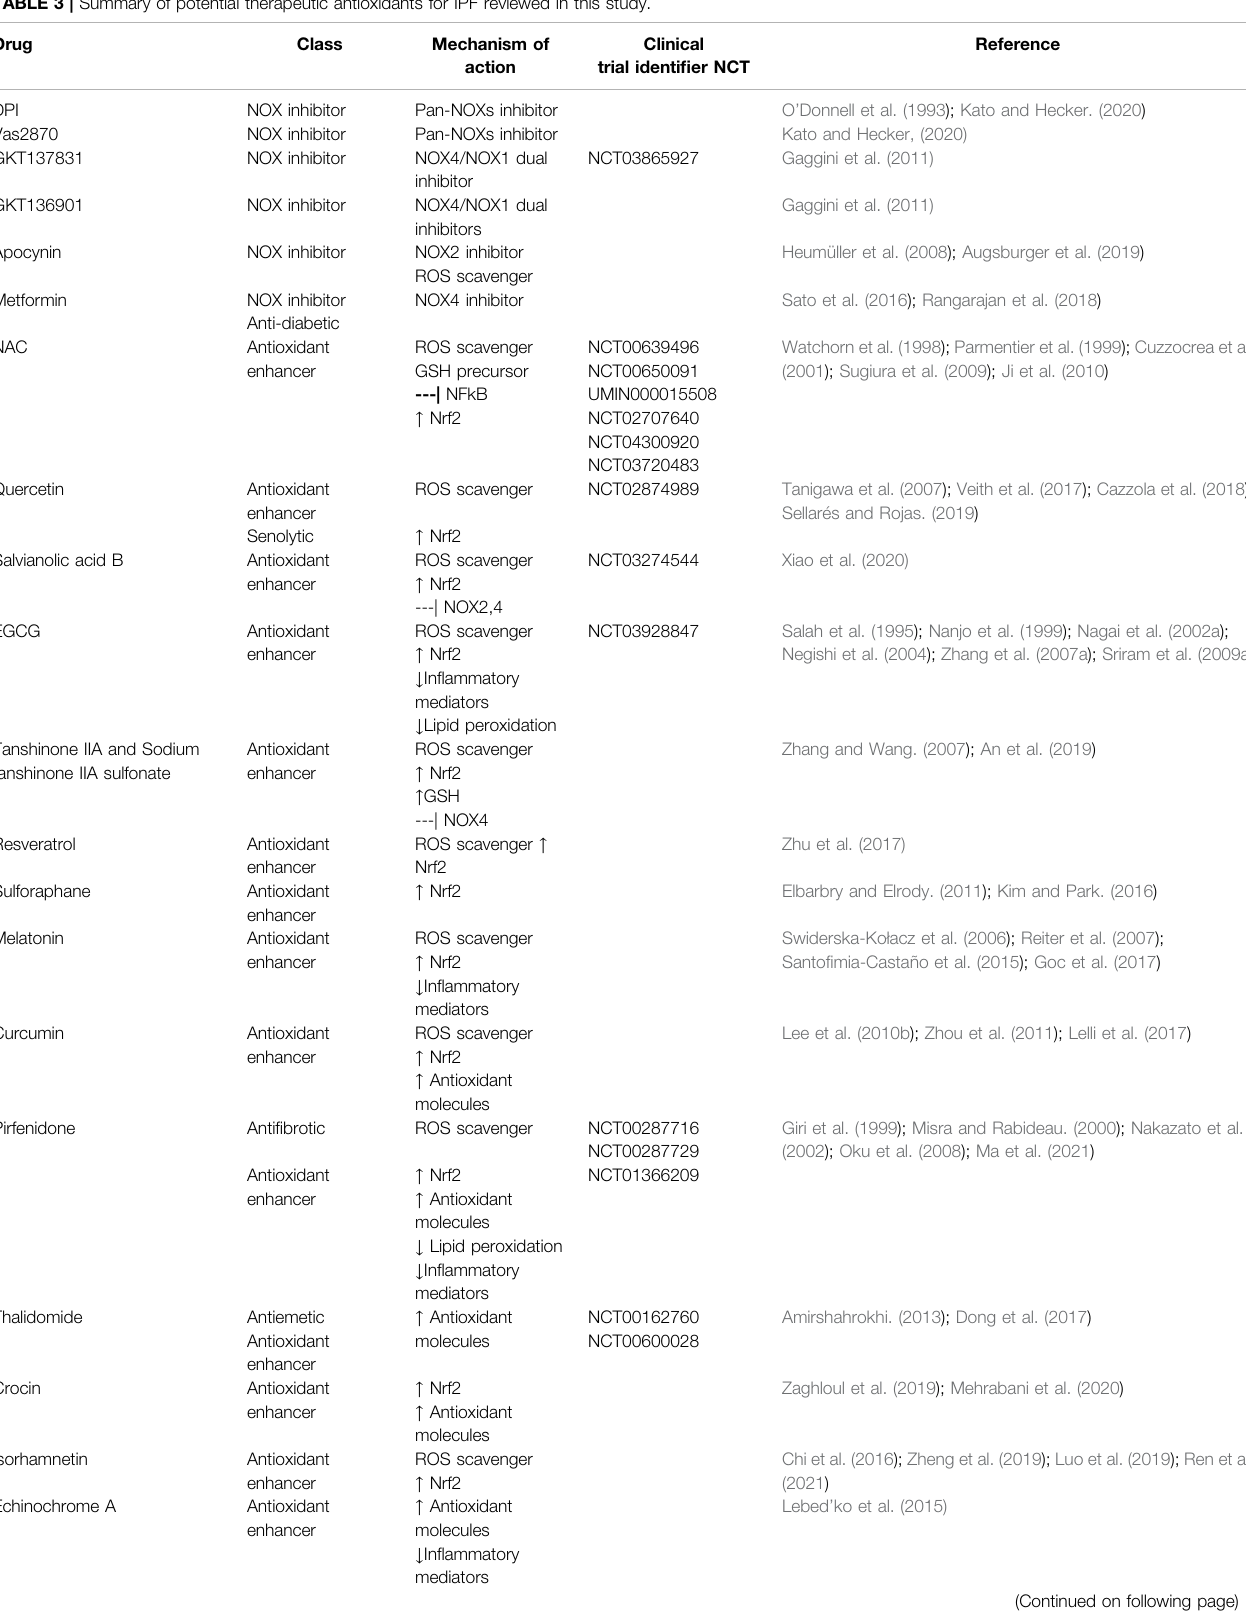
TABLE 3 | Summary of potential therapeutic antioxidants for IPF reviewed in this